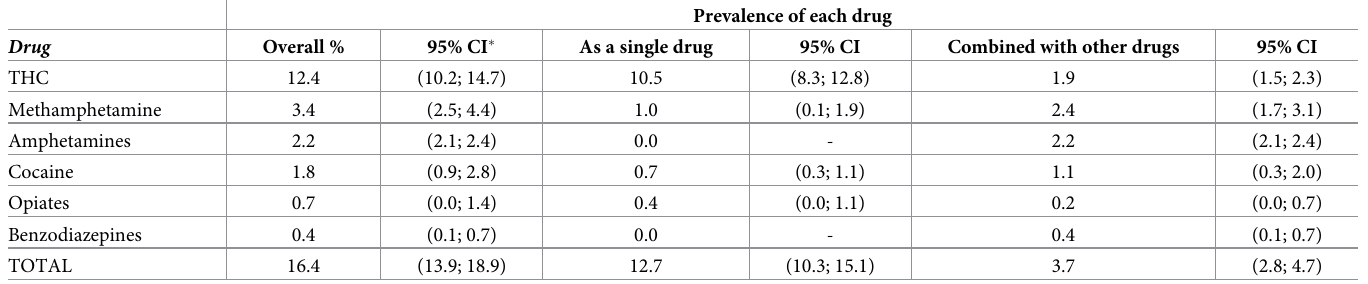
Table 3. Prevalence and 95% confidence intervals (CI) for specific drugs and their combinations.